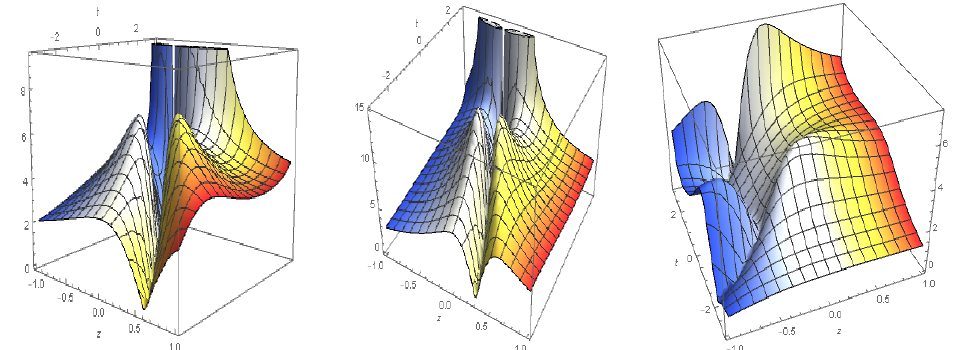
Figure 5. The lump two stripe graphs of the solution ∆ 3 in Equation (13) are interpreted via distinct values of ω = 5, k 1 = 2, ρ = 4, γ = − 1, k 2 = 1, k 3 = 1, k 4 = 2, b 0 = 3. Three-dimensional profiles at